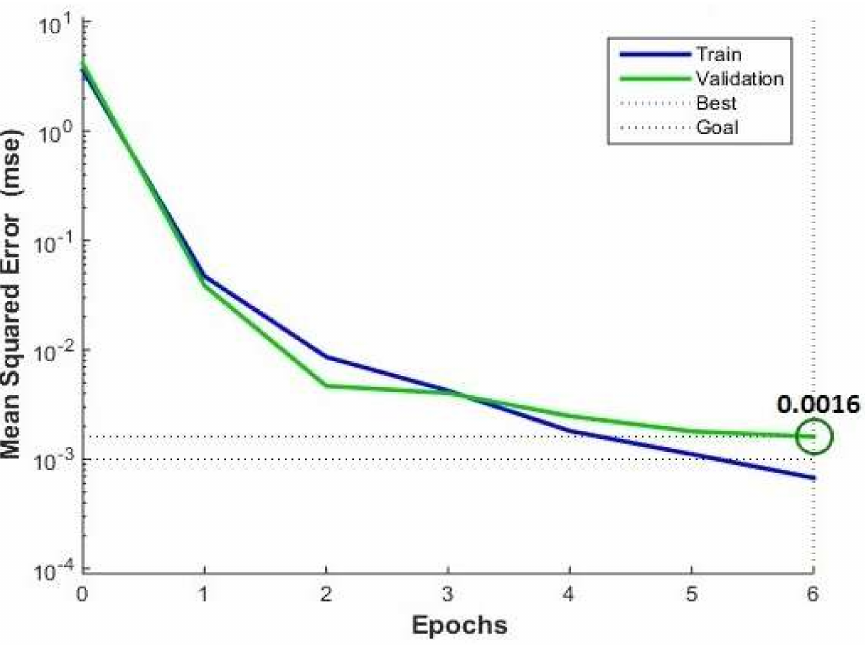
Figure 2. Neural network’s training performance.